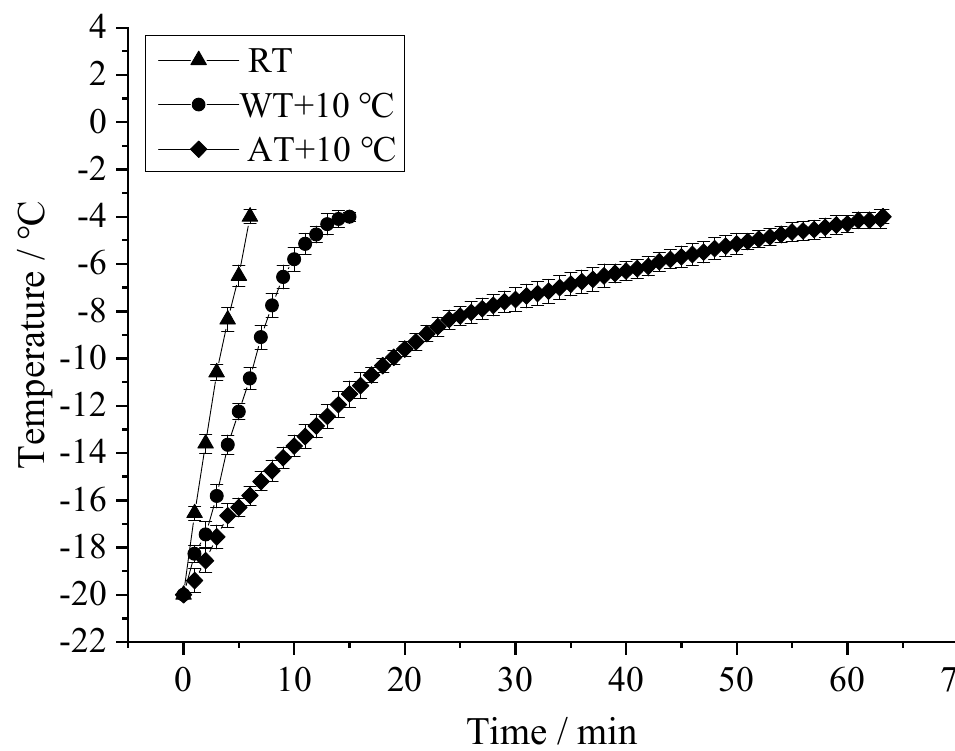
Figure 3. Temperature–time histories of salmon samples during different tempering treatments. (RT: Radio frequency tempering; WT+10 ˚C: Water tempering at 10 ± 0.5 ˚C; AT+10 ˚C: Air tempering at 10 ± 1 ˚C).